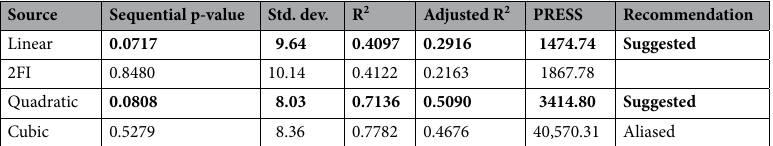
Source Sequential p-value Std. dev. R 2